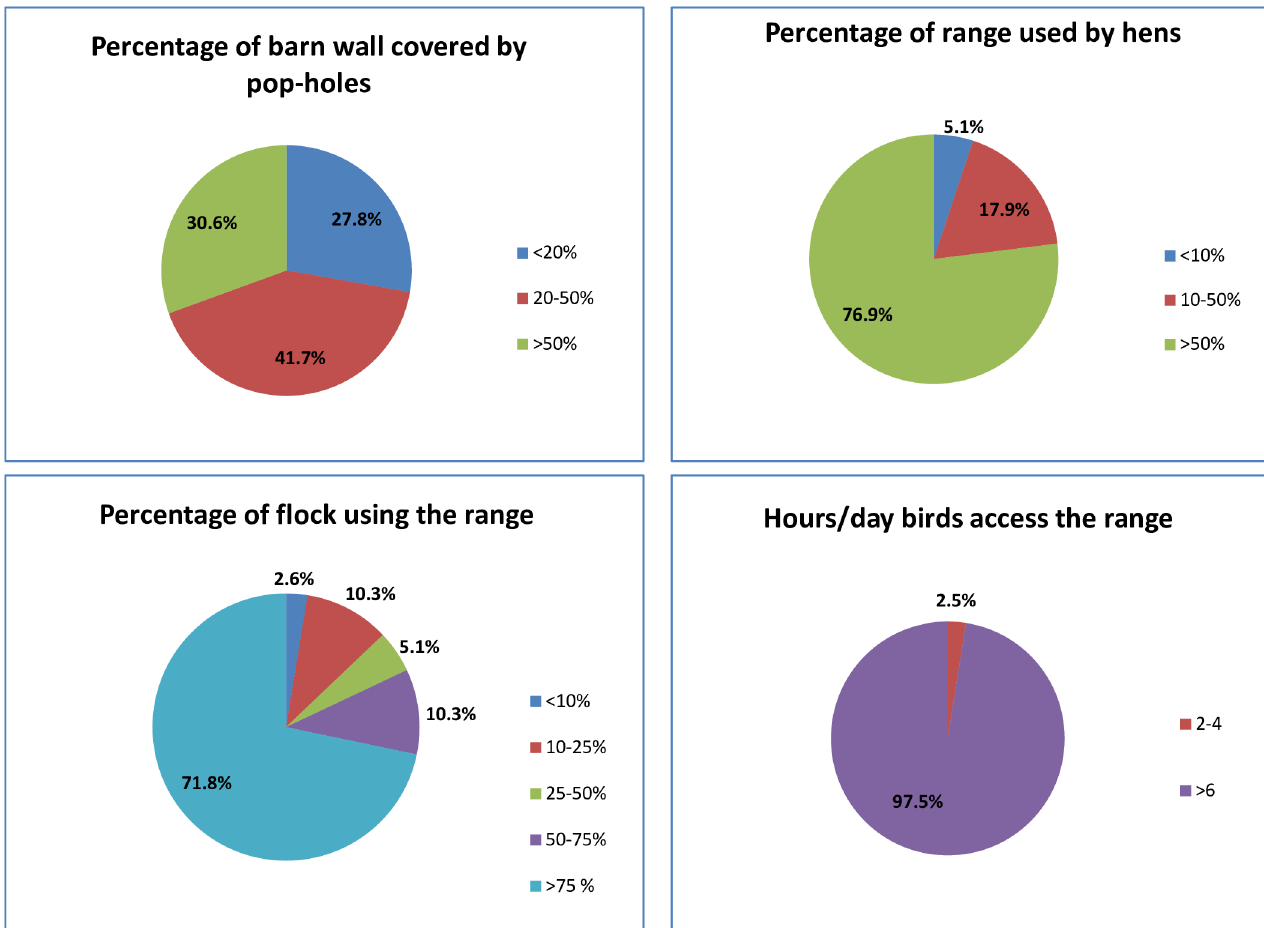
Fig 1. Range accesson respondent free-rangefarms with a stocking density of 1500 hens/hectare. (a) Percentageof barn wall covered by pop-holes(b) Percentageof range used by hens (c) Percentageof flock using the range area (d) Hours/daybirds access the range.